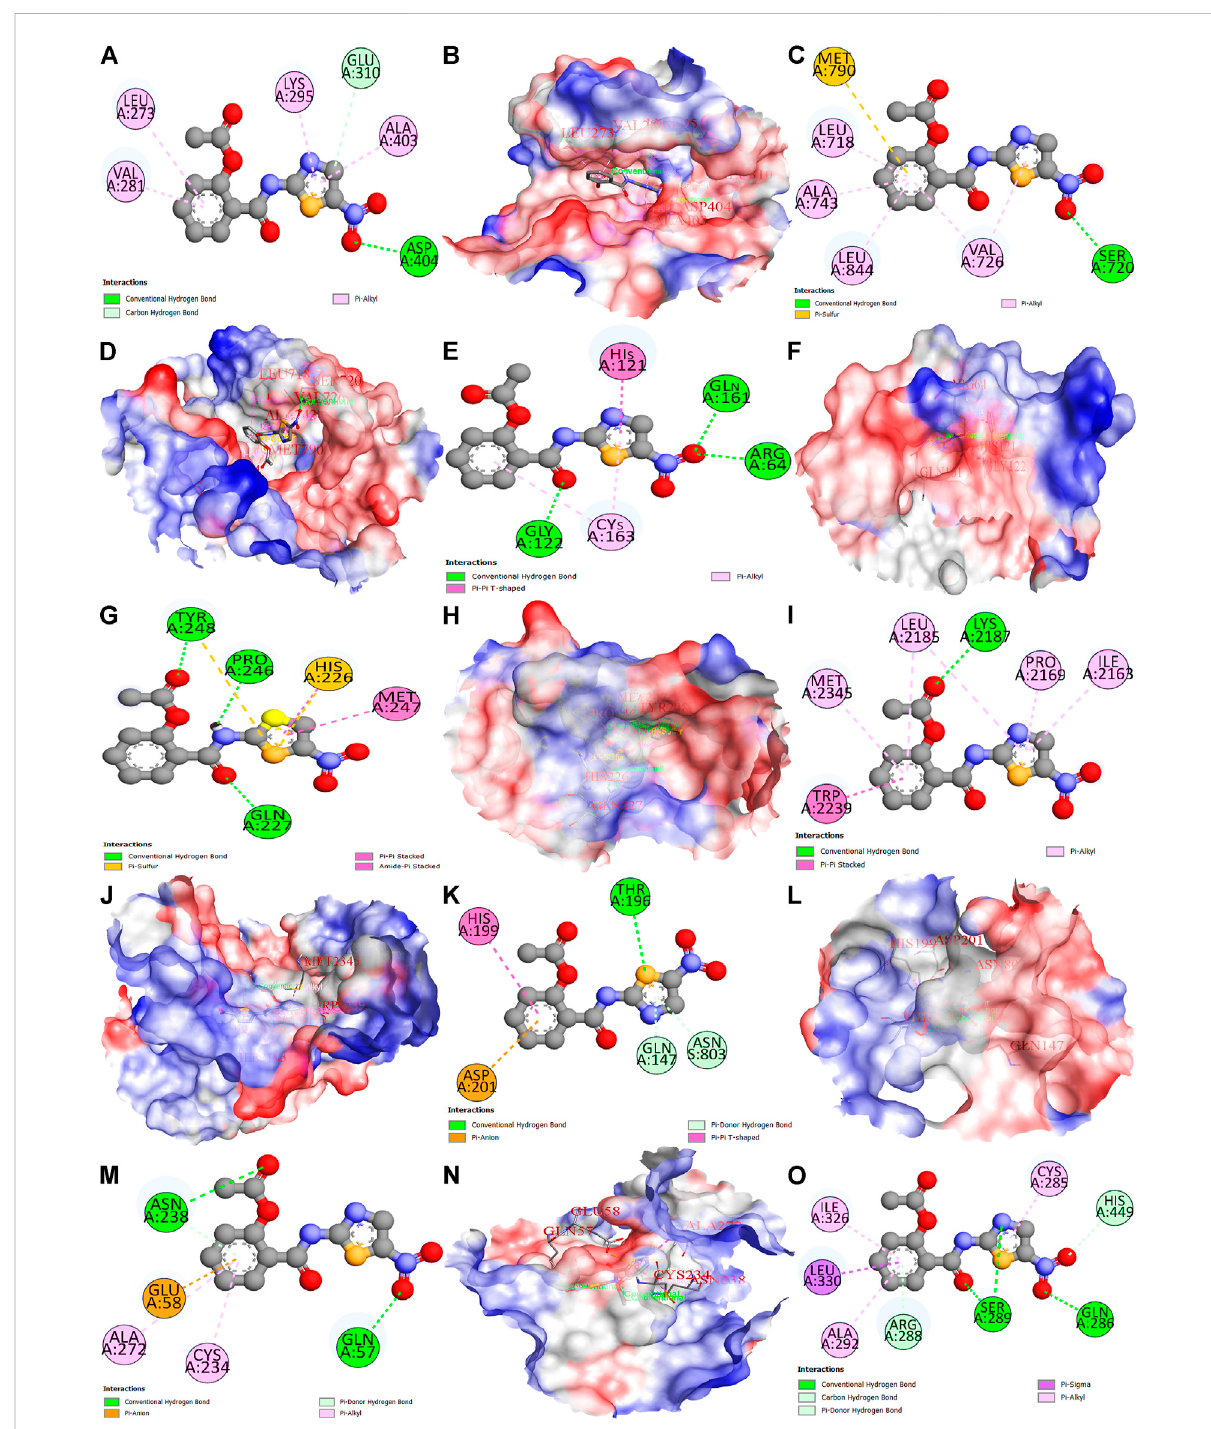
FIGURE 11 Moleculardockingresultsoftopeightanti-HCCcoretargetswithnitazoxanidedrug.NitazoxanidedrugbindswithSRC(2Dand3D) (A,B) ,EGFR (2Dand 3D) (C,D) , CASP3 (2Dand 3D) (E,F) , MMP9 (2D and3D) (G,H) ,mTOR (2Dand3D) (I,J) , HIF1A (2Dand 3D) (K,L) , ERBB2(2D and3D) (M,N) , and PPARG (2D) (O)